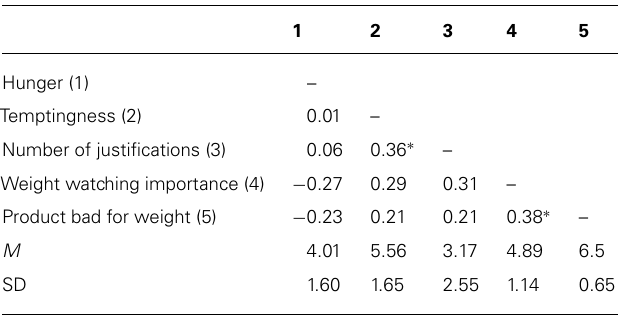
Table 3 | Study 2: means, SDs, and Correlations (Study